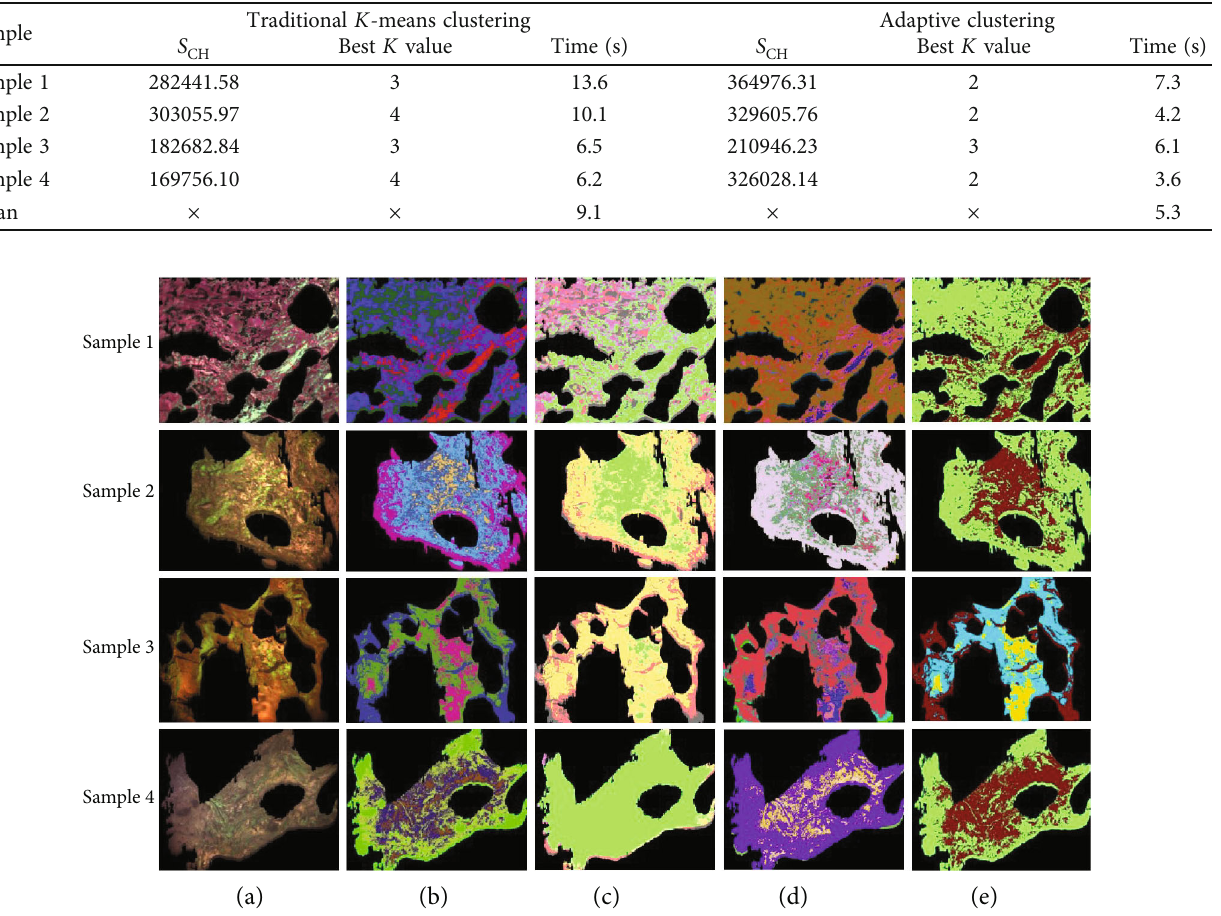
Figure 16: The clustering e ff ect of several di ff erent methods: (a) the main body of the COT image; (b) traditional K -means algorithm; (c) FCM algorithm; (d) Meanshift algorithm; (e) proposed method.